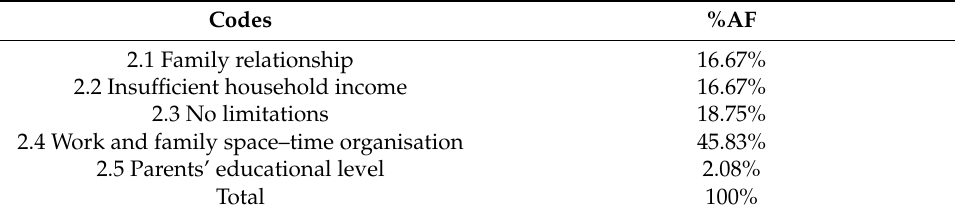
Table 2. Category 2 codes. Leisure and cultural